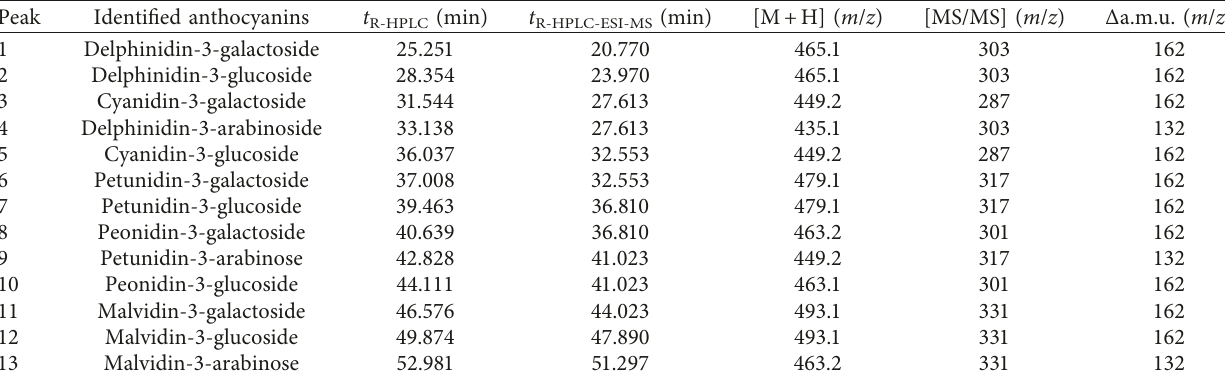
Table 4: Identified anthocyanins from rabbiteye blueberry